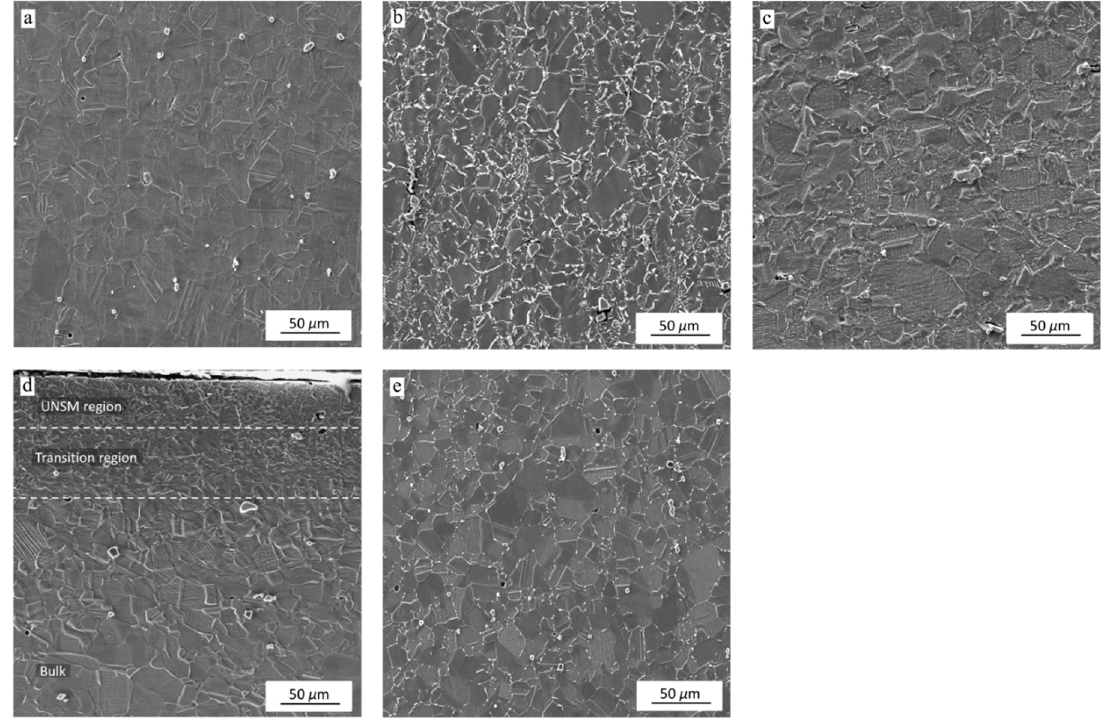
Figure 8. SEM (scanning electron microscopy) images showing the cross-section microstructure of Inconel 718: ( a ) As-received sample ( × 600), ( b ) I1 sample ( × 600), ( c ) I2 sample ( × 600), ( d ) I3 sample ( × 600) and, ( e ) I4 sample ( × 600).